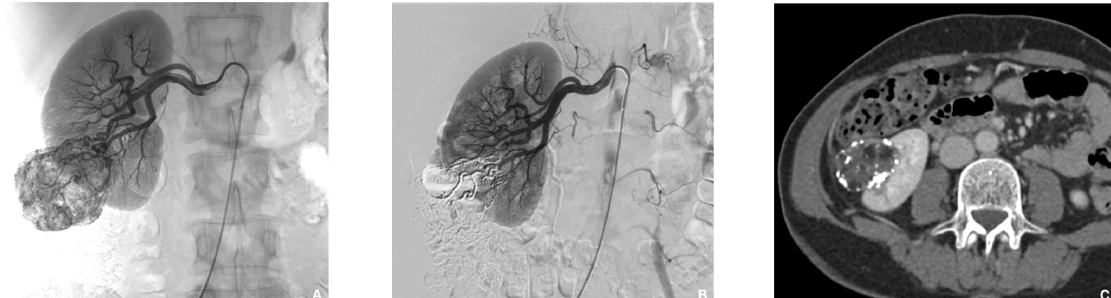
Figure 6. Prophylactic selective embolization of a large angiomyolipoma of the right kidney. ( A ) Angiography shows two feeding arteries to the angiomylipoma which is hypervascular. ( B ) Final control after selective and fast embolization of the two arterial branches with a Glubran ® 2/Lipiodol ® mixture of a 1:6 ratio. ( C ) Computed tomography scan at day 14 showing lipiodol uptake by the angiomyolipoma which is totally devascularized.